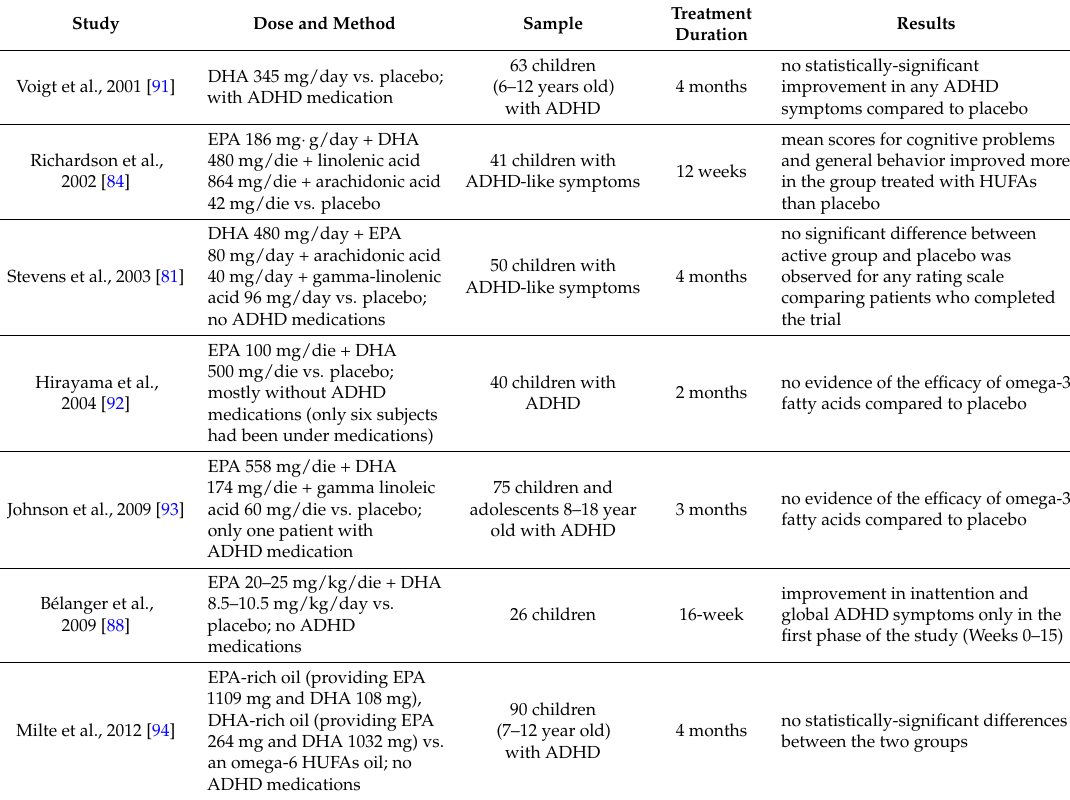
Table 4. Double-blind controlled trials of HUFAs in the treatment of